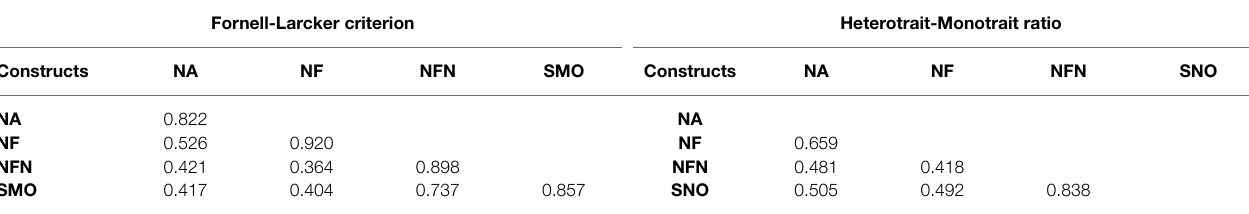
TABLE 3 | Discriminant validity.